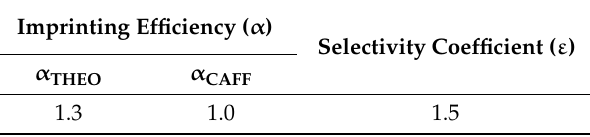
Table 2. Imprinting efficiency ( α ) and selectivity coefficient ( ε